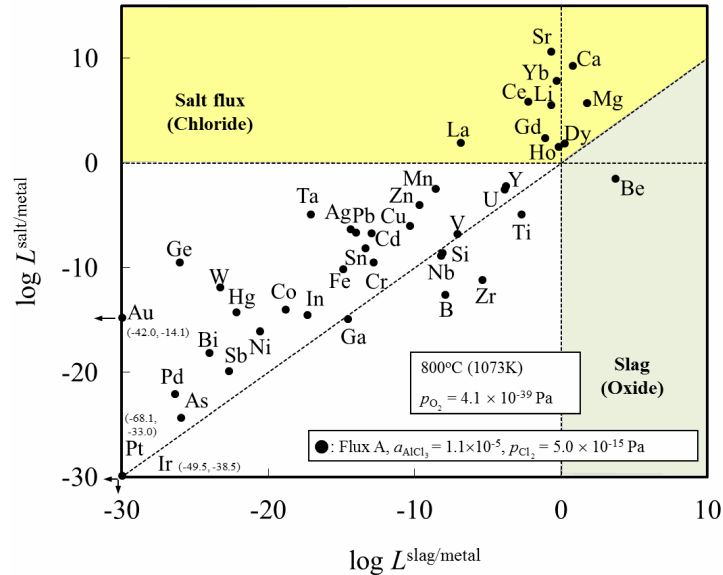
Figure 1. Distribution chart of elements among slag (oxide), salt flux (chloride), and metal phases under the simulated atmosphere of the aluminum melting process.